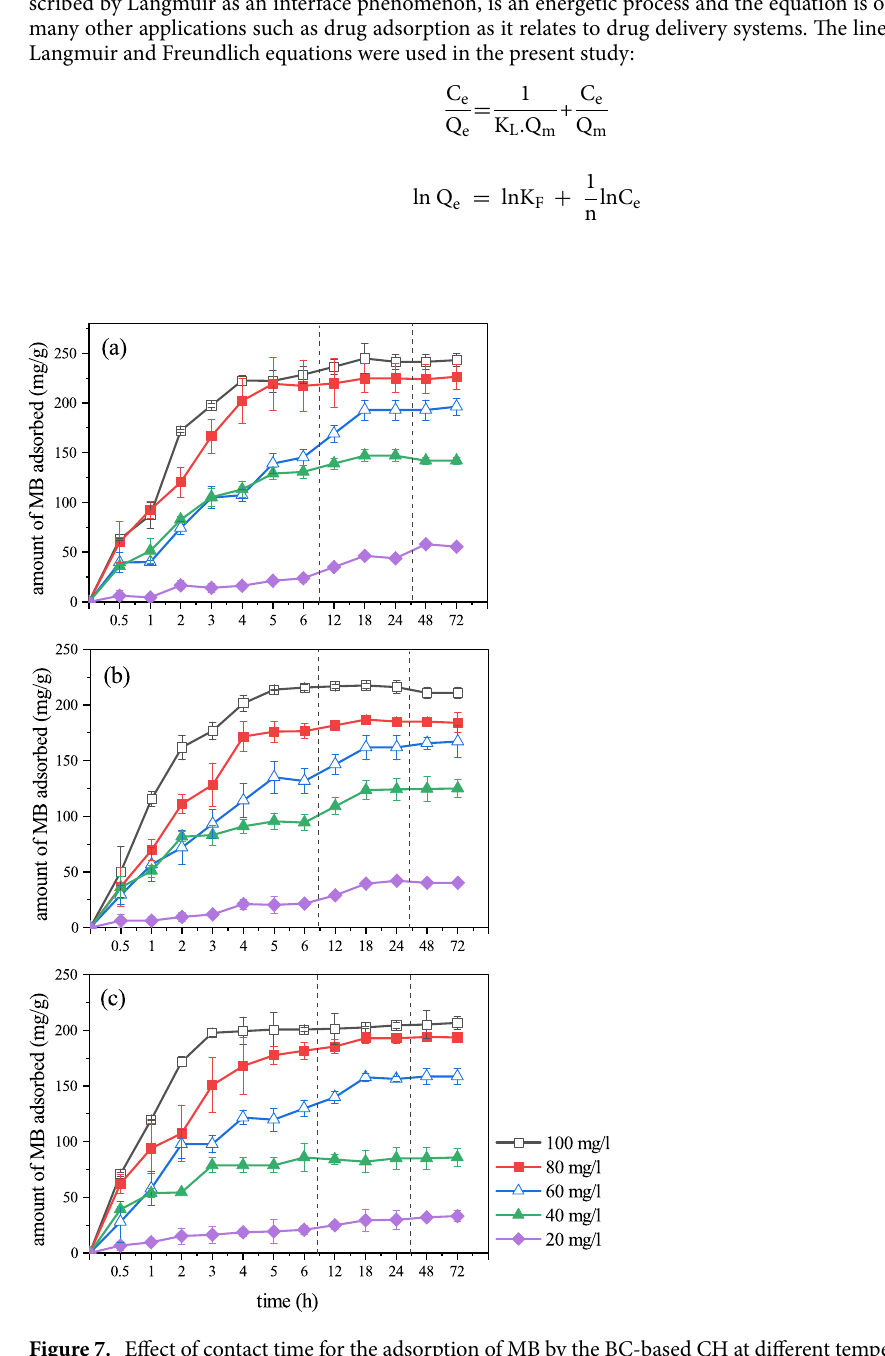
Figure 7. Effect of contact time for the adsorption of MB by the BC-based CH at different temperatures: ( a ) 27 °C, ( b ) 37 °C, and ( c ) 47